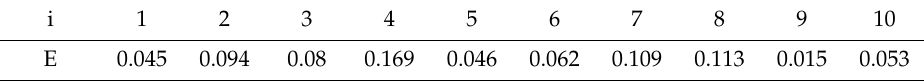
Figure 2. Comparison between the frequencies evaluated by experimental and numerical tests. Table 3. Absolute percent error of frequencies values estimated with experimental and numerical tests.